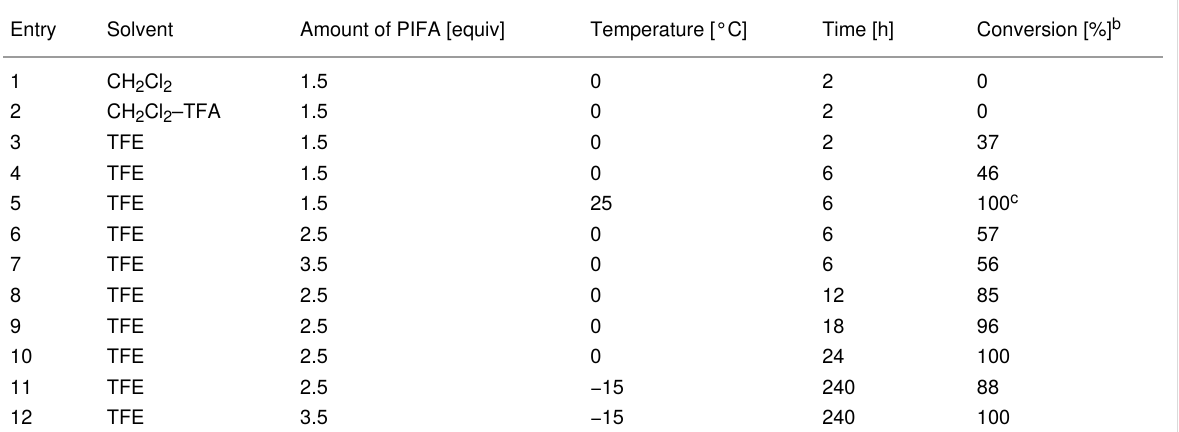
Table 2: Optimization of the reaction conditions a